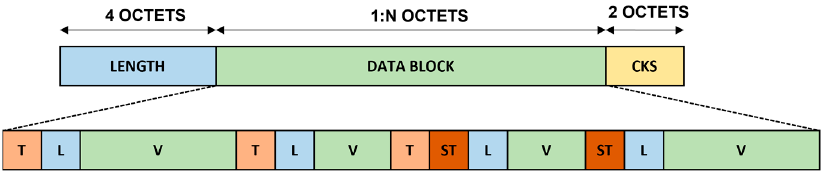
Figure 7. TEDS file format: T = type, ST = subtype, L = length, V = value, and CKS = checksum. Type 02 and type 03 have the same meaning for all the TEDSs. In particular, type 03 corresponds to the TEDS identifier, the corresponding length is equal to 4 octets and the value field is composed of 4 parameters: family identifies the member of the IEEE 21451 family of standard (e.g., value = 0 for the Dot 0), class identifies the kind of TEDS and it represents the TEDS access code (e.g., 1 for Meta TEDS, 3 for transducer channel TEDS, and 5 for Calibration TEDS), version is the standard release (e.g., 1 corresponds to the original Dot 0 release), and tuple length specifies the number of octets in the length field of the TLV data structures for a given TEDS (usually this value is equal to 1).